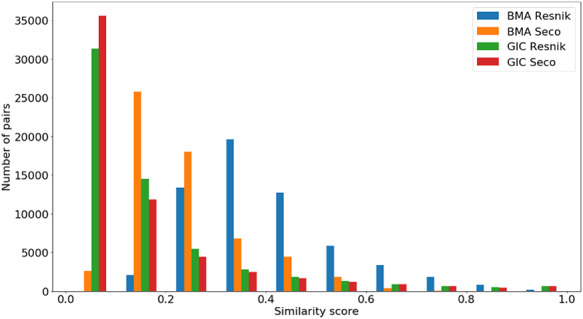
Distribution of all semantic similarity metrics (\documentclass[12pt]{minimal}
\usepackage{amsmath}
\usepackage{wasysym}
\usepackage{amsfonts}
\usepackage{amssymb}
\usepackage{amsbsy}
\usepackage{upgreek}
\usepackage{mathrsfs}
\setlength{\oddsidemargin}{-69pt}
\begin{document}
}{}$BM{A_{Resnik}}$\end{document}, \documentclass[12pt]{minimal}
\usepackage{amsmath}
\usepackage{wasysym}
\usepackage{amsfonts}
\usepackage{amssymb}
\usepackage{amsbsy}
\usepackage{upgreek}
\usepackage{mathrsfs}
\setlength{\oddsidemargin}{-69pt}
\begin{document}
}{}$BM{A_{Seco}}$\end{document}, \documentclass[12pt]{minimal}
\usepackage{amsmath}
\usepackage{wasysym}
\usepackage{amsfonts}
\usepackage{amssymb}
\usepackage{amsbsy}
\usepackage{upgreek}
\usepackage{mathrsfs}
\setlength{\oddsidemargin}{-69pt}
\begin{document}
}{}$simGI{C_{Resnik}}$\end{document} and \documentclass[12pt]{minimal}
\usepackage{amsmath}
\usepackage{wasysym}
\usepackage{amsfonts}
\usepackage{amssymb}
\usepackage{amsbsy}
\usepackage{upgreek}
\usepackage{mathrsfs}
\setlength{\oddsidemargin}{-69pt}
\begin{document}
}{}$simGI{C_{Seco}}$\end{document}) values across all species’ protein pairs in the protein–protein interaction data sets.